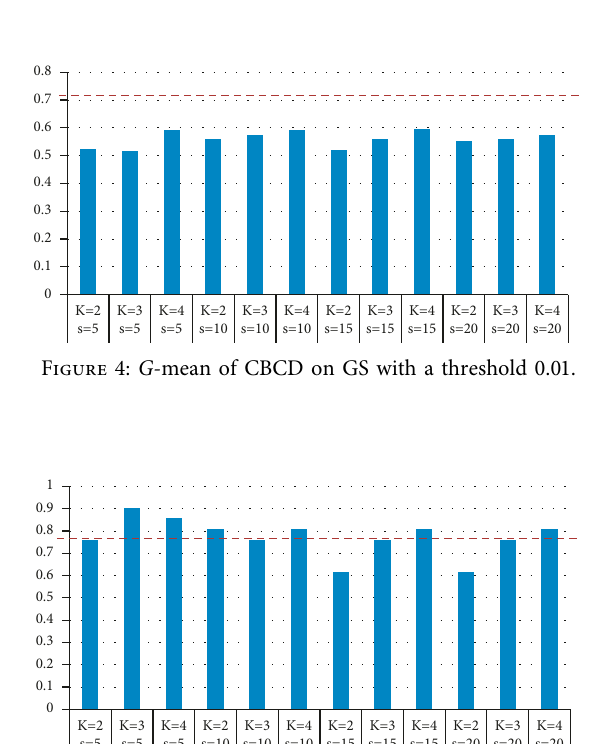
Figure 7: G -mean of CBCD on GS with a threshold 0.005.